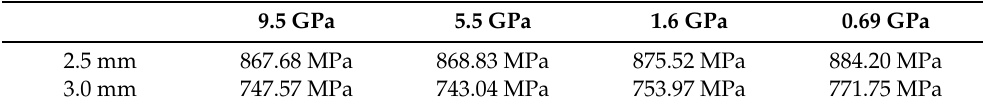
Table 7. Cortical bone 2.5 mm/3.0 mm (oblique force) von Mises stress